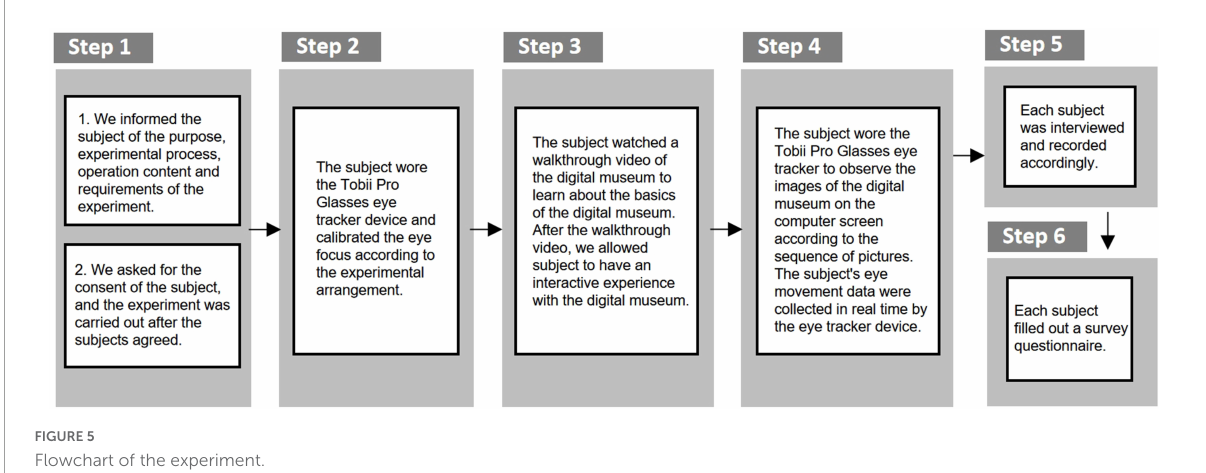
FIGURE5 Flowchart of the